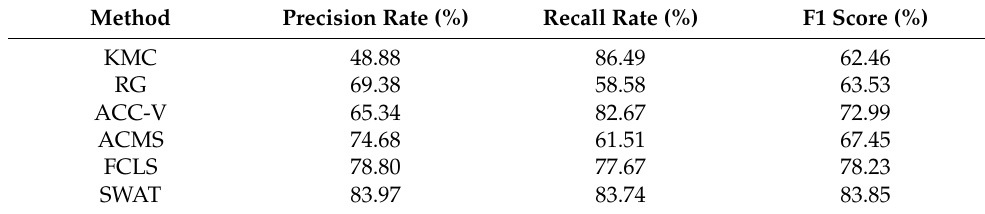
Table 1. Statistical analysis of different methods on DIARETDB1